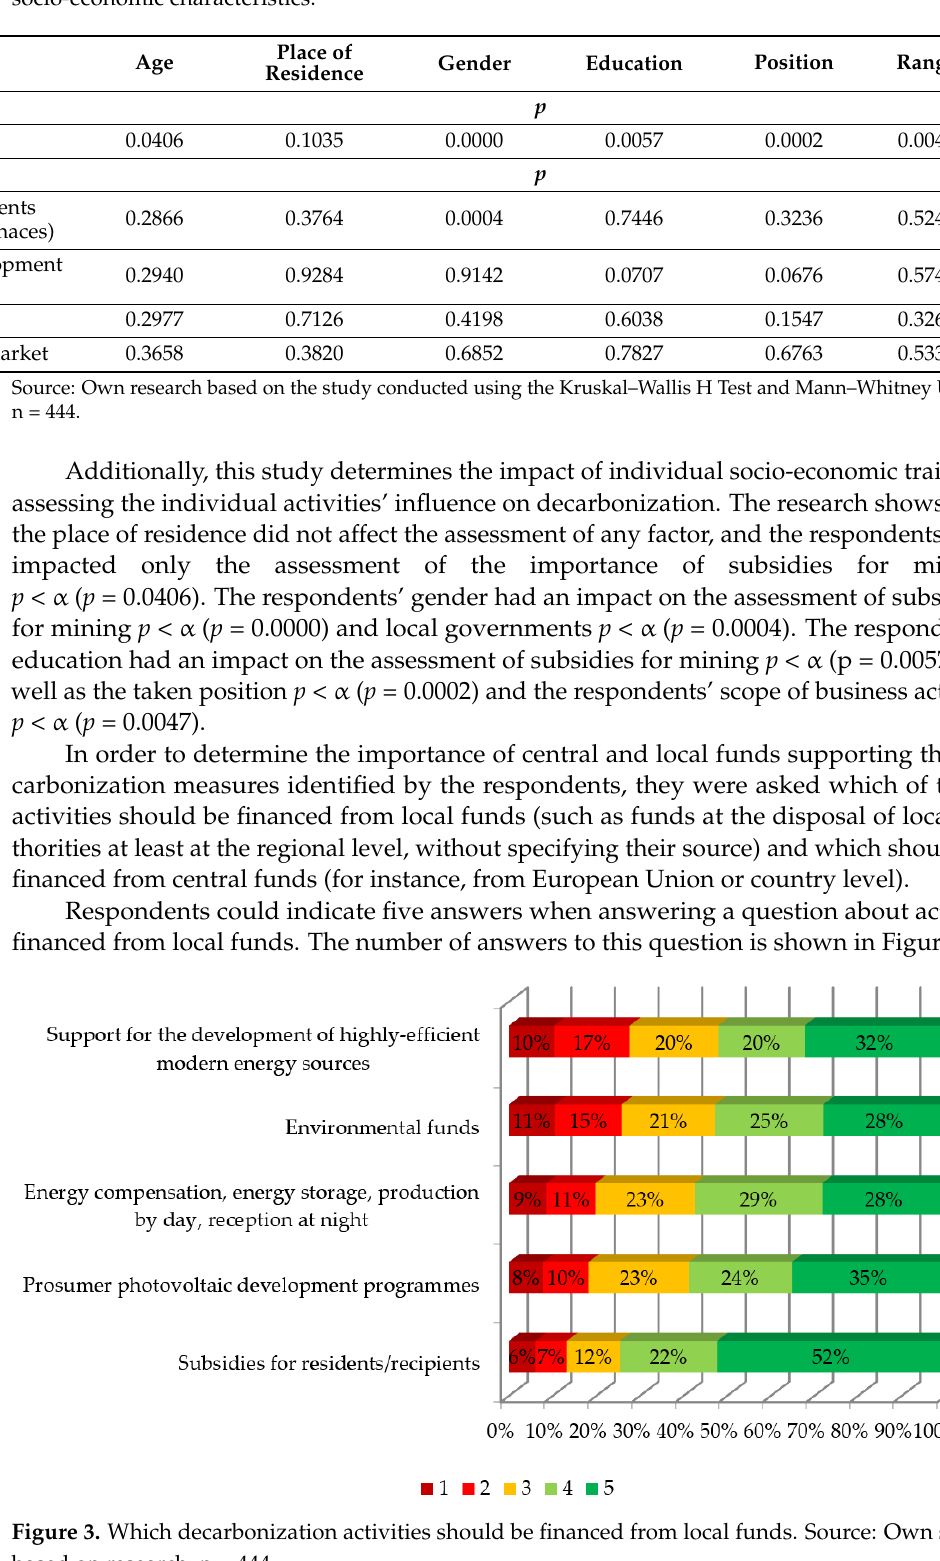
Table 4. Evaluation of decarbonization activities to be financed from local funds (counts) and basic descriptive statistics (mean and standard deviation). Source: Own study based on research, n = 444.